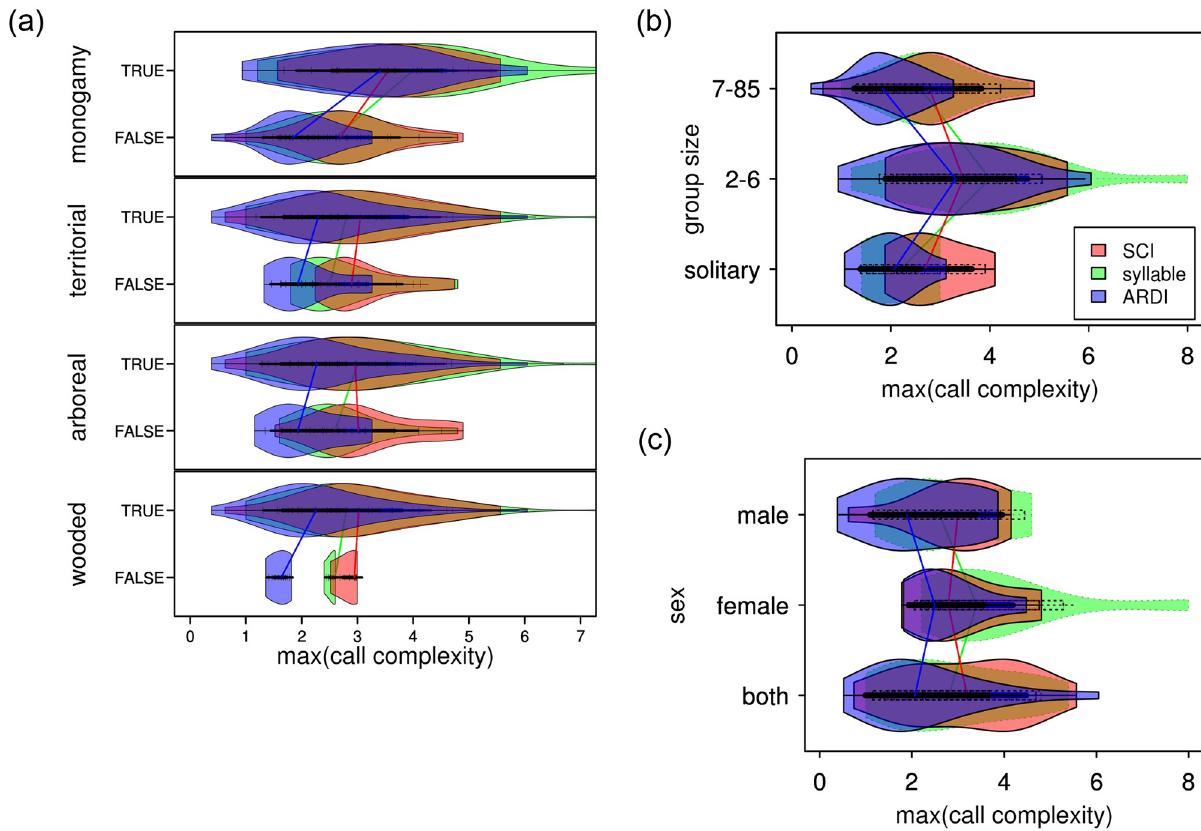
Fig 9. Violin plots of call complexity versus socioecological variables. a. Music origins hypotheses include territorial defense, pair-bonding, [139] and acoustic adaptation to habitat. The mean scores for each of these species level factors exceed their corresponding false values, indicating all of them could have an influence on display musicality. Social monogamy appears to have the strongest association with call complexity. ARDI has results that parallel syllable count with scores generally a full integer lower after discounting by its reappearance factor. SCI interestingly seems to be much less influenced by habitat factors than ARDI which has strong responses in both wooded and arboreal . But also notice that ARDI has the steepest slope differentiating monogamous status. Colors are the same as in Figs 5 and 7b, with overlaps producing additive mixes between rgb colors on the color wheel (e.g. amber = green+red, violet = blue+red). b. The highest vocal complexity scores occur in small group size species (e.g. duetting primates such as gibbons, tarsiers, and callitrichids). ARDI scores for solitary, neighborhood-living species were robust against down-weighting by reappearance . SCI similarly seems to be less influenced by group size factors than ARDI but confirms that smaller groups may exhibit a more noticeable musicality. c . In our species level dataset, the most complex calls (via ARDI and syllable) are female generated. SCI, however, seems to indicate that vocalization types performed by both sexes are more complex. Together, these results possibly contraindicate sexual selection (for male display) primarily driving call complexity in primates. Alternatively, however, females (e.g. gibbons) could instead be attracting extra-pair mates as a side-effect of their territorial (e.g. great) calls, in counter-point to social (and pair) bonding